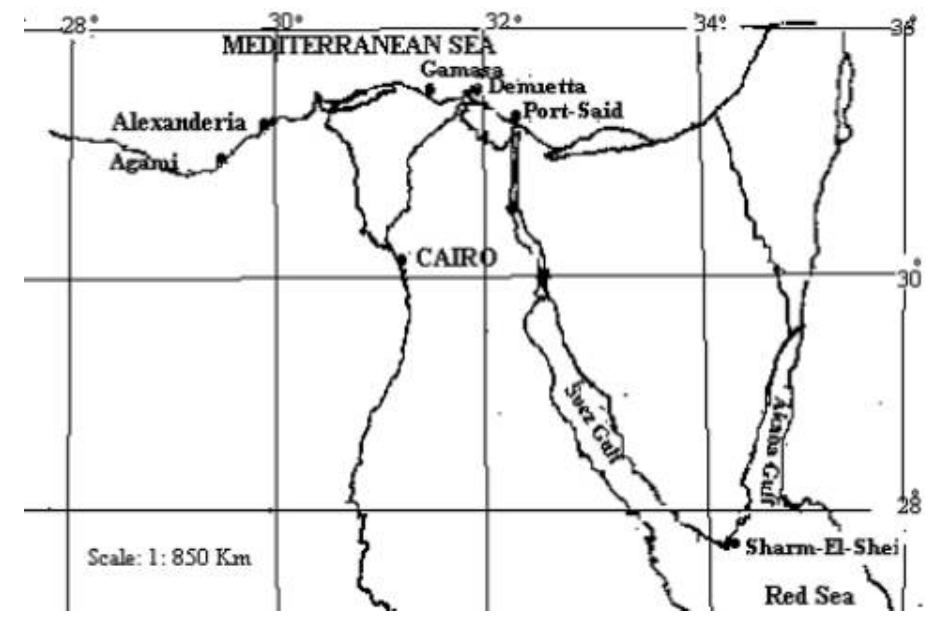
FIGURE 1. The site locations of the sediment samples: Agami (A), Damietta (D), Port Said (P), Gamasa (G), and Sharm El-Sheikh (S).